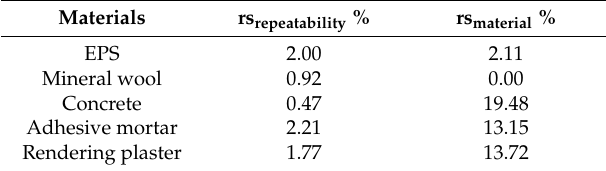
Table 4. The average repeatability error and material error of related tests.